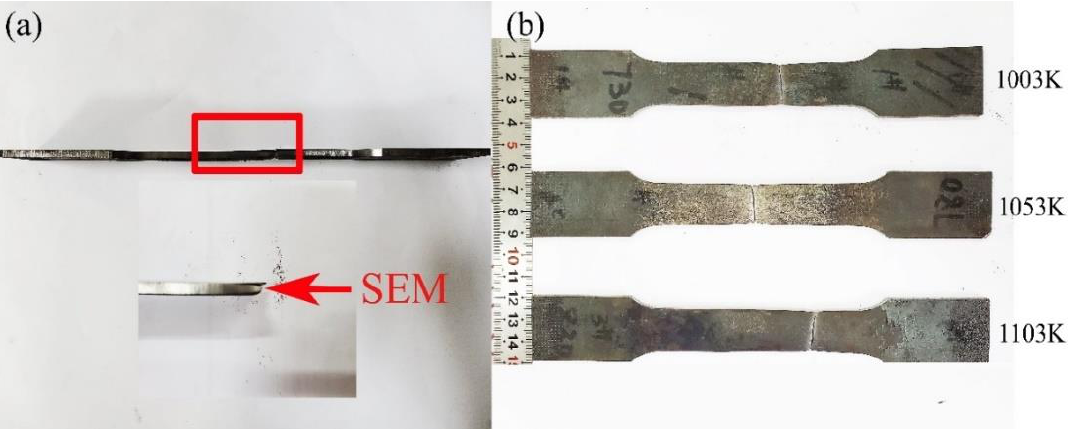
Figure 13. Macroscopic morphology of sheets rolled at different temperatures after tensile fracture. Figure 13. ( a ) The area of SEM of fracture profiles, ( b ) Macroscopic morphology of sheets rolled at di ff erent temperatures after tensile